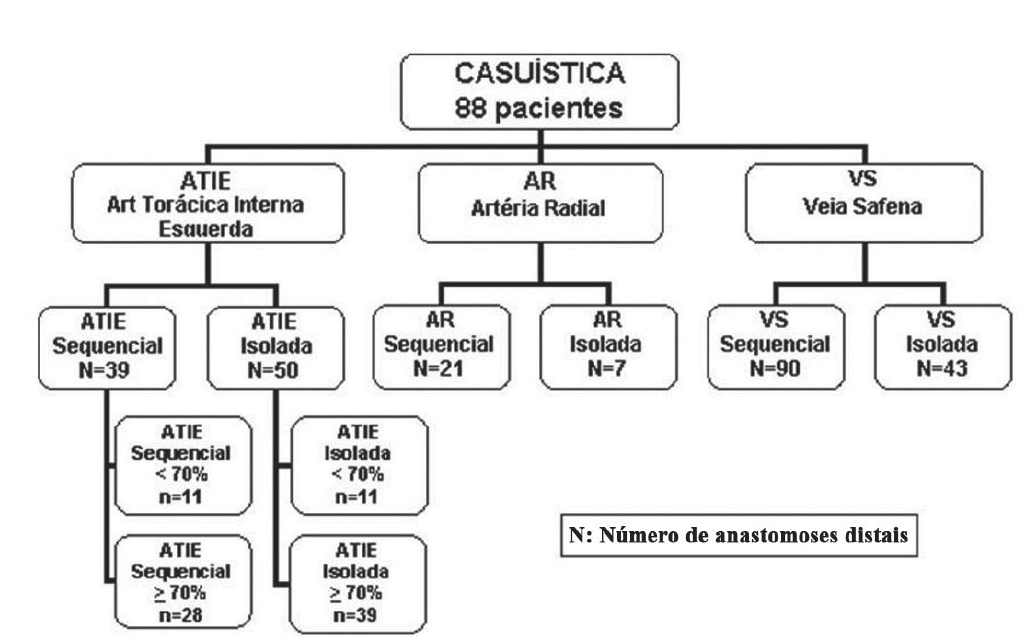
Fig. 1 - Caracterização dos grupos